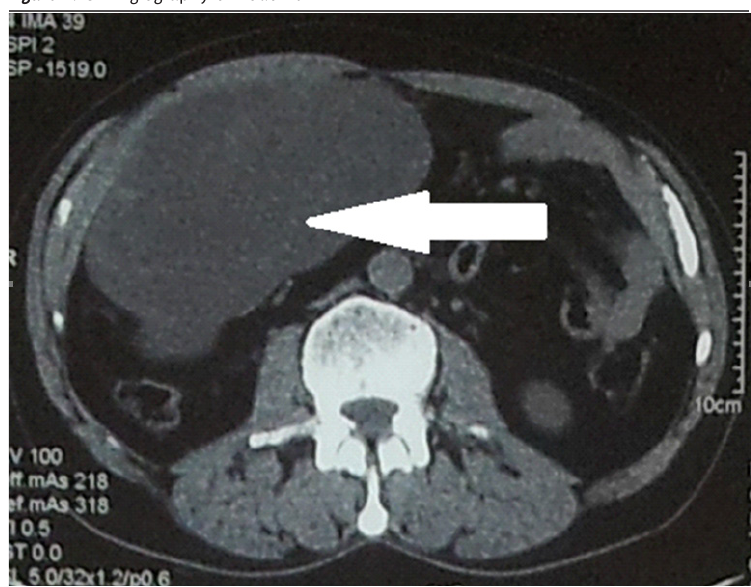
Figure 1. CT Angiography of Abdomen